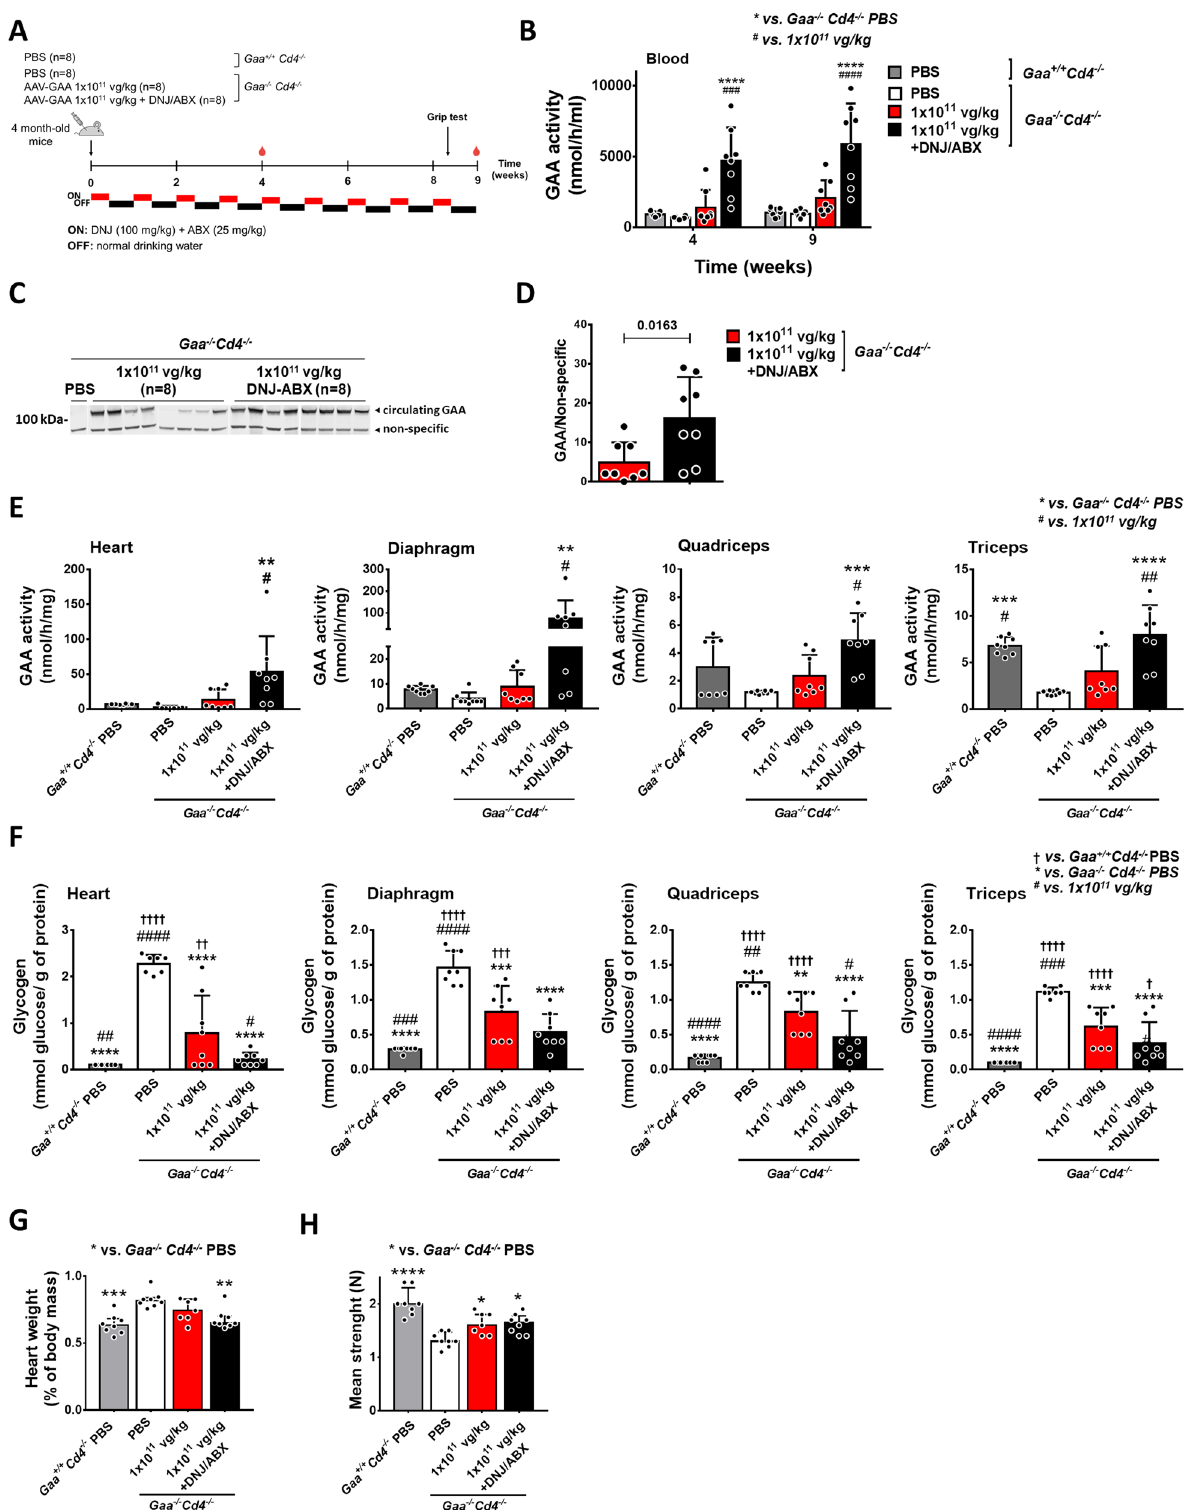
Translational optimization and scale up to non-human pri- mates (NHPs) demonstrate tissue uptake of hepatocyte expressed GAA . In an effort toward clinical translation, we codon-optimized the GAA cDNA sequence initially tested in Pompe mice. The transgene expression cassette was then pack- aged into an AAV-Spark100 capsid, which has demonstrated hepatocyte tropism in humans 39 . The optimized AAV vector was